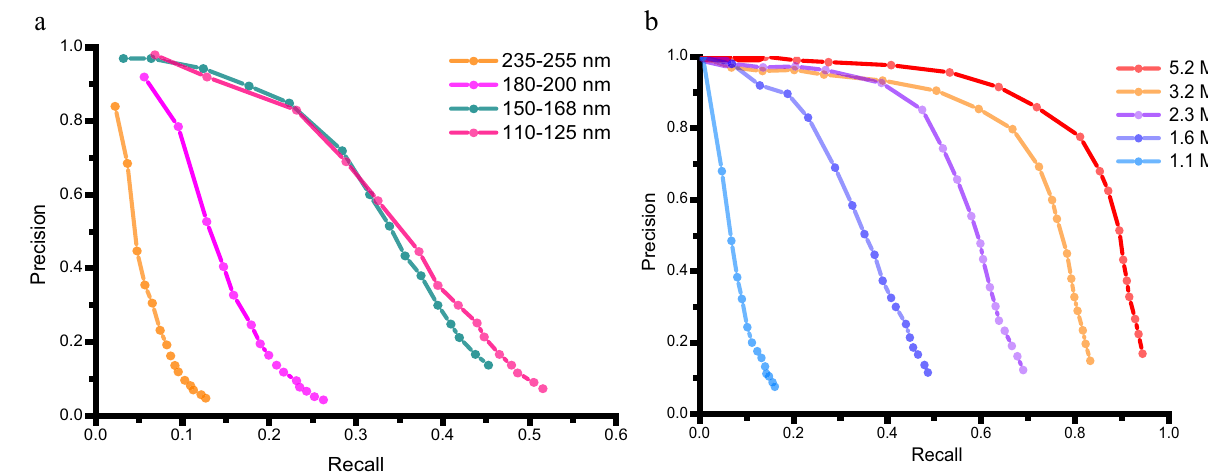
Fig. 3 | Precision-recall curves. a Precision-recall curves of the localization on images with a thickness range of 110 to 125nm (pink), 150 − 168nm (olive), 180 – 200nm (magenta) and 235 – 255nm (orange). The target protein is 1.6 MD in molecular weight. b Precision-recall curves of the localization of target proteins in